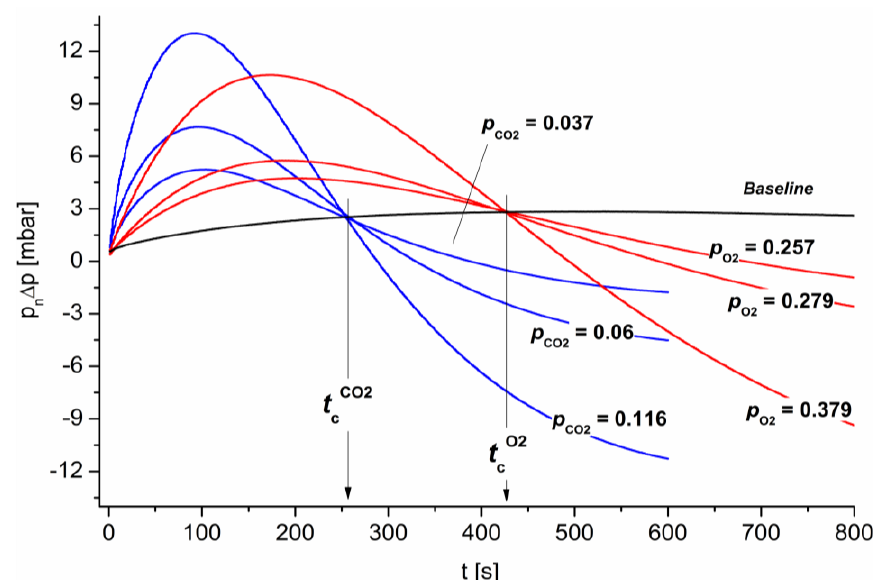
Figure 10. Experimental validation: Gas-dependent evolution of the differential pressure. CO and O were added to the air gas matrix in various quantities. The resultant contents 2 2 are indicated. The individual sensor responses intersect the baseline at a gas-specific critical time, independent of the